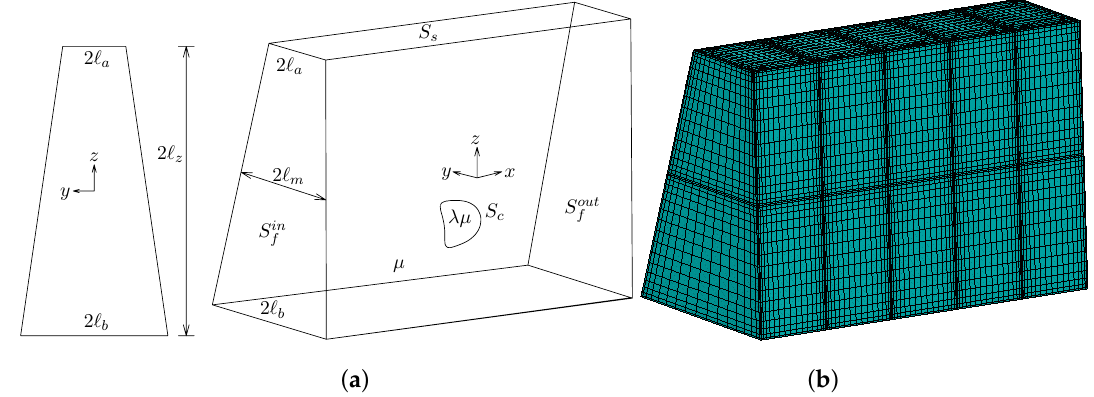
Figure 1. Illustration of ( a ) an isosceles trapezoidal channel with a flowing elastic capsule, and ( b ) a spectral boundary element discretization of the